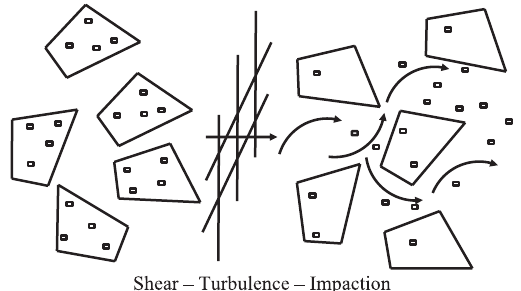
Fig. 5 Schematic of small drug particles at the surface of large lactose carrier particle depicting their liberation as a function of airflow and air path features.